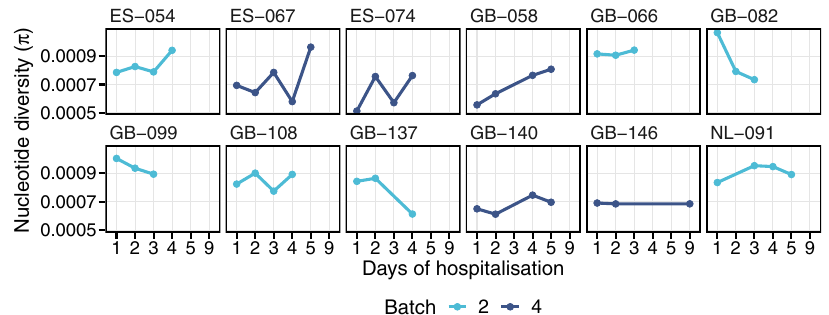
Fig. 3 Temporal change of pairwise nucleotide diversity. Pairwise nucleotide diversity of serial samples collected at more than two time points and sequenced in the same batch are shown here. Three participants whose samples were sequenced in different batches and 19 participants who had only two samples collected are not shown. Each panel is labelled with the participant ID.